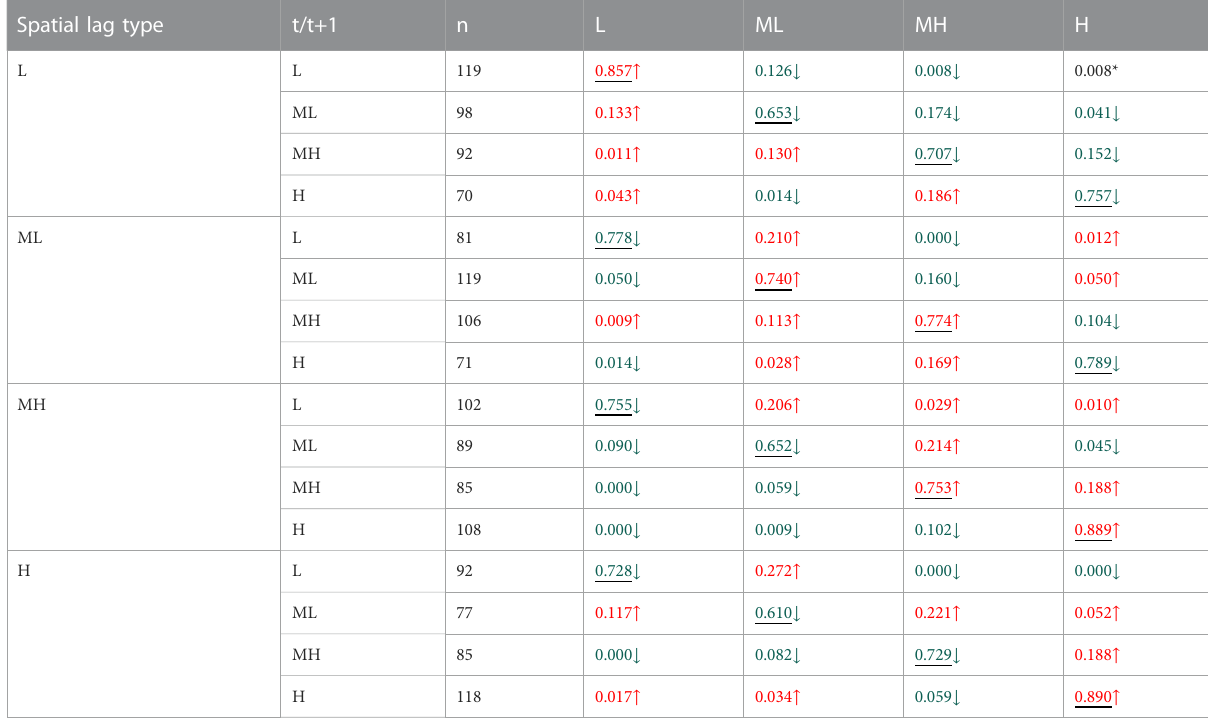
TABLE 6 Markov transfer probability matrix of ULGUE in the Yangtze River Economic Belt. Spatial lag